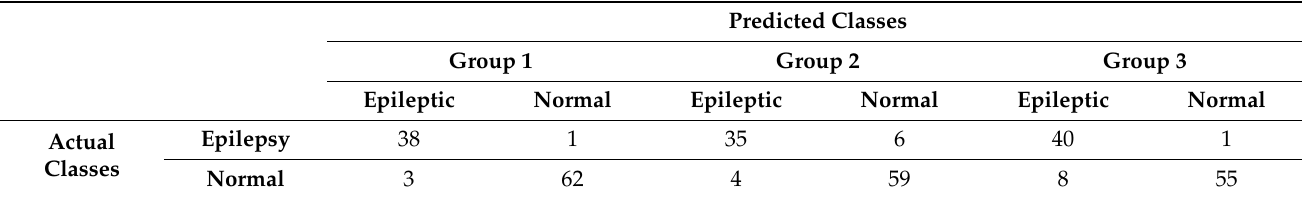
Table 3. The details of the confusion matrix for the three groups of